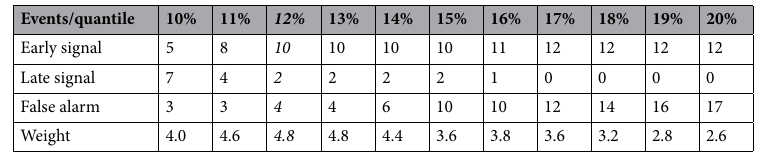
1 norm of the zero-